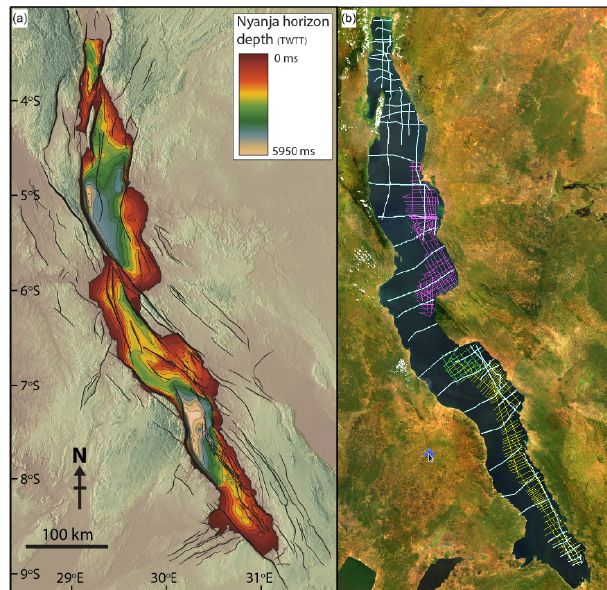
Figure 2. In panel (a) , a contour map shows the two-way travel time from lake surface to acoustic basement (i.e., the Nyanja Event) deduced from seismic reflection data shown within a regional digi- tal elevation model based on 90m Surface Radar Topography Mis- sion data. Major interpreted faults are shown. In panel (b) , a map of seismic lines collected from Lake Tanganyika overlain on a satellite image (© Esri imagery – source: Esri, i-cubed, USDA, USGS, AEX, GeoEye, Getmapping, Aerogrid, IGN, IGP, UPR- EGP, and the GIS). Light blue lines are 24-fold multichannel seis- mic lines collected by Project PROBE 1993–1984. Green lines are single-channel sparker profiles collected during the Nyanza Project (McGlue et al., 2008). Yellow profiles are 60-fold data acquired in 2012 as part of a commercial exploration program. Magenta lines are single-channel high-resolution air-gun profiles collected in